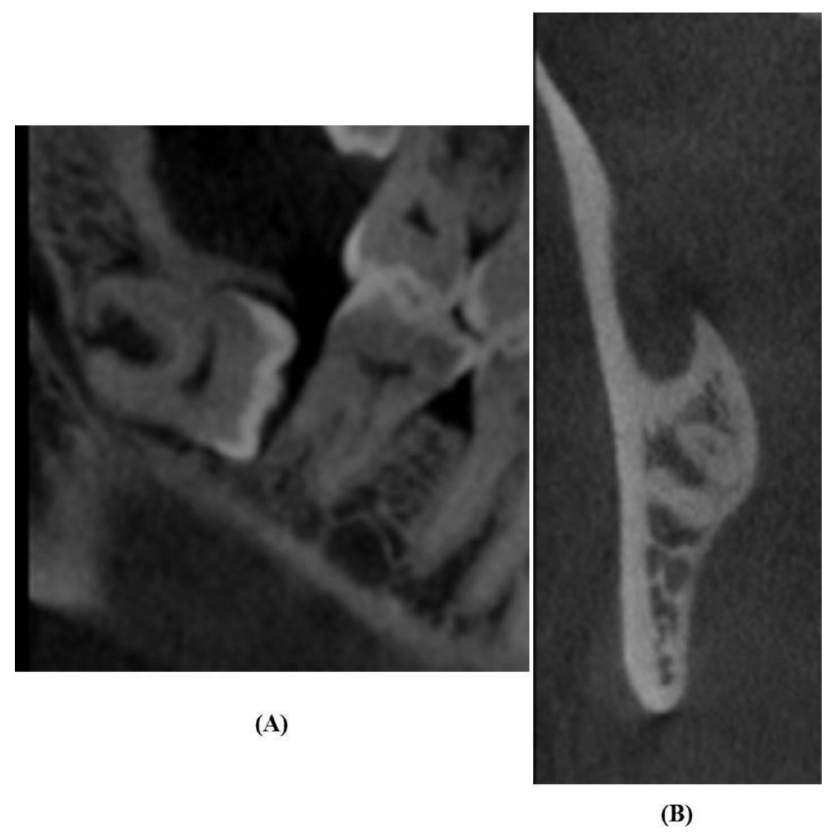
Figure 4. Panoramic images show diversion of mandibular canal ( A ), and buccally positioned inferior alveolar canal without cortication on CBCT images ( B